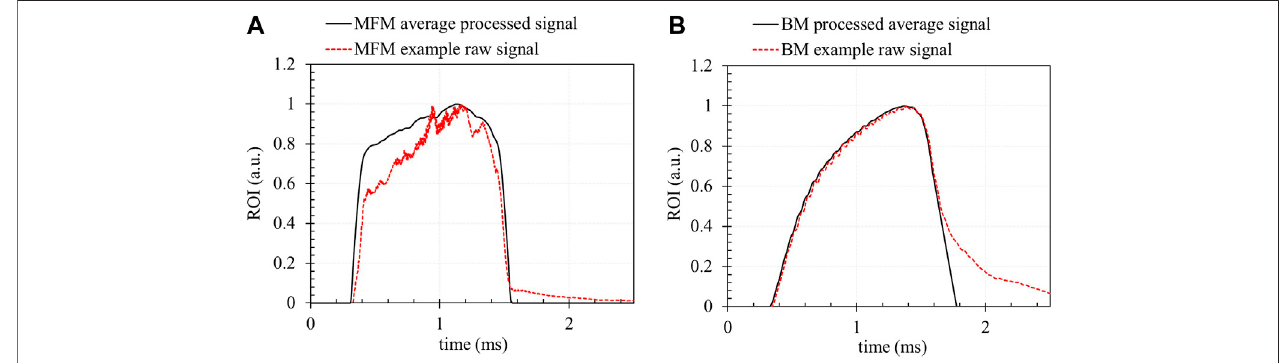
FIGURE 2 | Illustration of an example raw signal compared to the post-processed average ROI [ (A) momentum fl ux method MFM. (B) Bosch tube method BM]. Conditions: injection pressure 1500 bar; duration of injection (DOI) 1 ms.